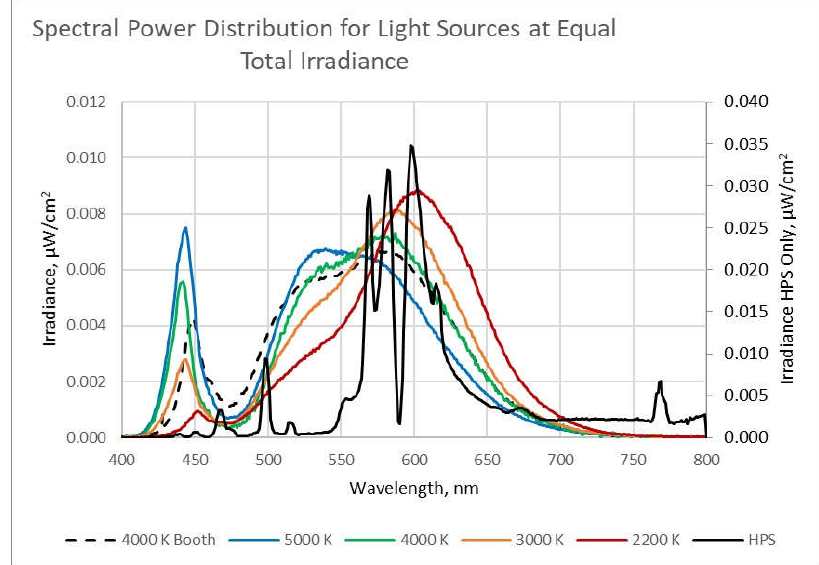
Figure 16. SPDs of the light sources used in the experiment. All light sources are plotted relative to the left-hand vertical scale, except for the HPS irradiance, which is plotted versus the right-hand vertical scale.